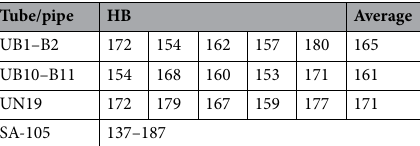
Table 5. Hardness measurement of elbows.